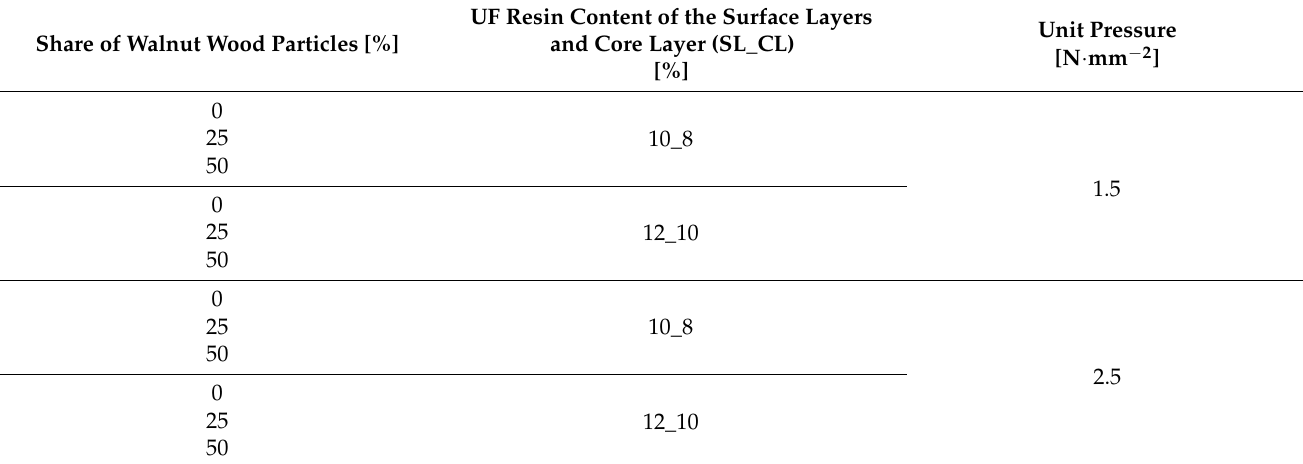
Table 2. Manufacturing parameters of particleboard fabricated from industrial wood particles and residual walnut wood particles bonded with UF